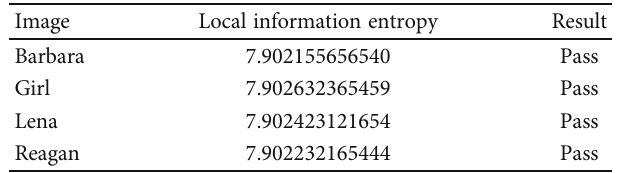
Table 7: Information entropy.